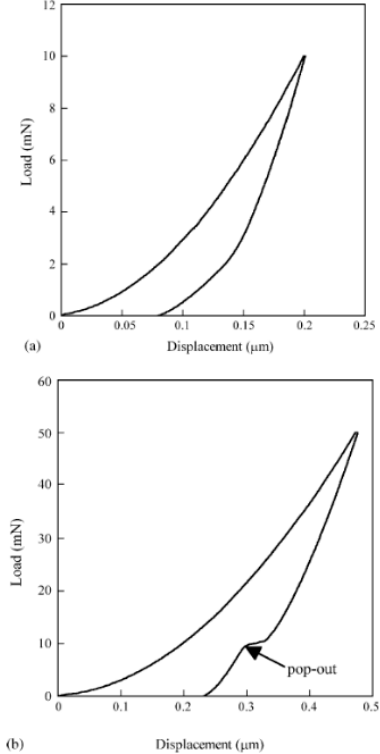
Figure 2. Typical load-depth indentation curve indicating phase transition in a single-crystal silicon wafer sample ( a ) as an elbow at 2 mN on the unloading curve of a measurement up to 10 mN and ( b ) as a pop-out event at about 10 mN in an experiment up to F max = 50 mN. Reproduced with permission from [8]. Copyright 2006, Elsevier (Amsterdam, The Netherlands).